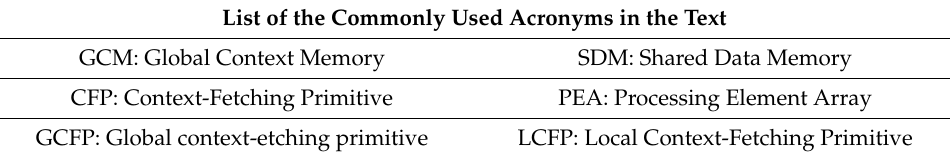
Figure 4. The overview of the context-reduction framework. Table 1. Commonly used acronyms